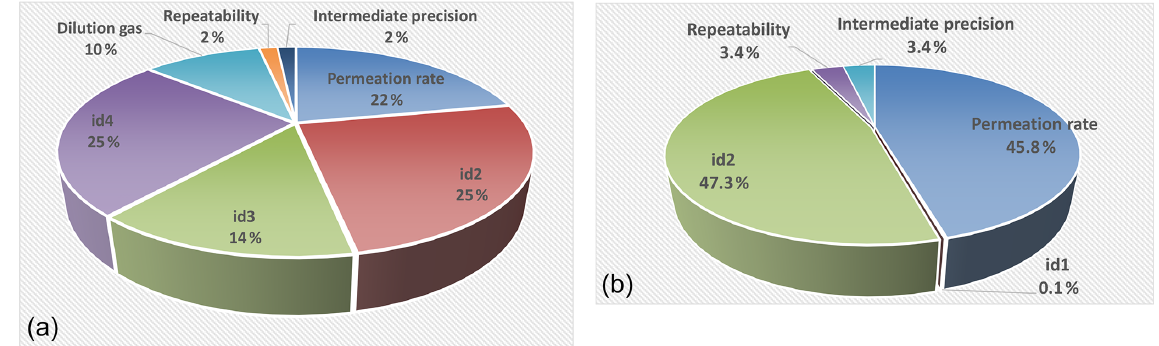
Figure 5. The distribution of the different uncertainty sources for NH 3 -calibrated amount-of-substance fractions from 1nmolmol − 1 (second stage of dilution; a ) and 400nmolmol − 1 (first stage of dilution; b ). The sources indicated as id1–id4 correspond to the mass flow controllers of the